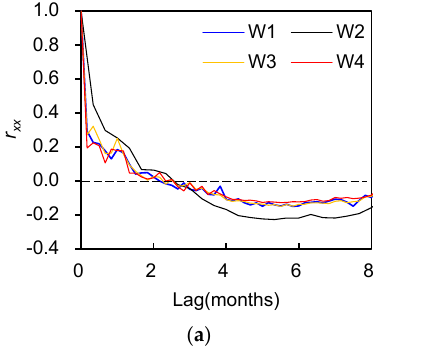
Figure 4. Auto-correlation functions for ( a ) rainfall, and ( b ) GWLs. Table 3. Parameters of the auto-correlation functions.